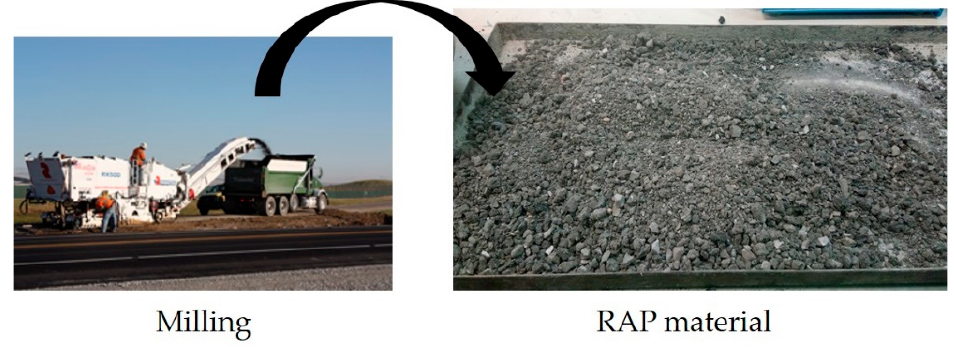
Figure 5. Reclaimed asphalt pavement (RAP)